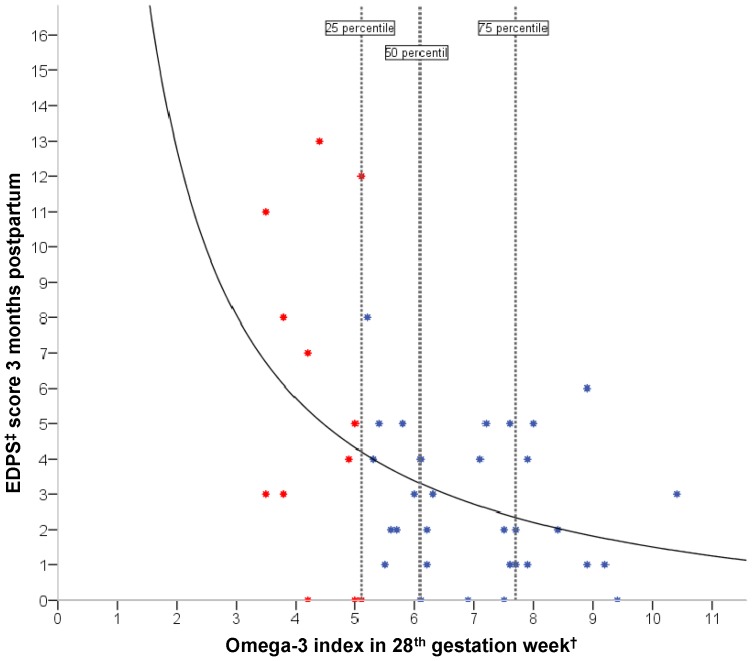
Association between the omega-3 index in pregnancy and postpartum depression.Scatter plot of the non-linear relationship between the marine omega-3 status (omega-3 index) in pregnancy and postpartum depression score (EPDS). A rectangular hyperbolic equation (y = -1.31+28.1/x) was the best fit for describing this relationship (ß = 0.43, F (1,41) = 9.32, p<0.004, n = 43). The vertical lines represent omega-3 index quartiles. Red markers represent individuals in the 25 percentile. † The content of EPA+DHA in red blood cells membranes expressed as a percent of total fatty acids ‡ Edinburgh postnatal depression scale.